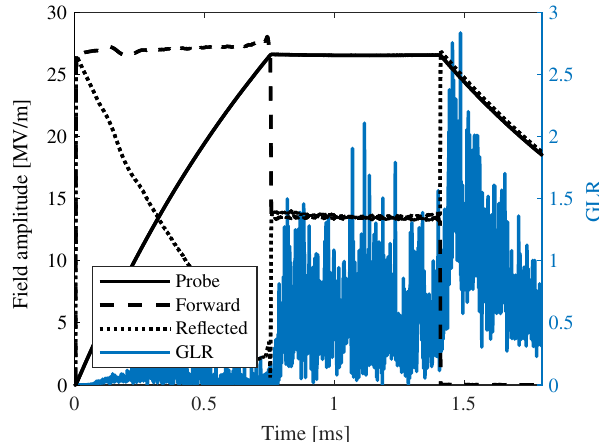
FIG. 13. Cavity rf signals and corresponding GLR for pulse 11 from Fig. 12 when Q L is changed. The threshold of is not